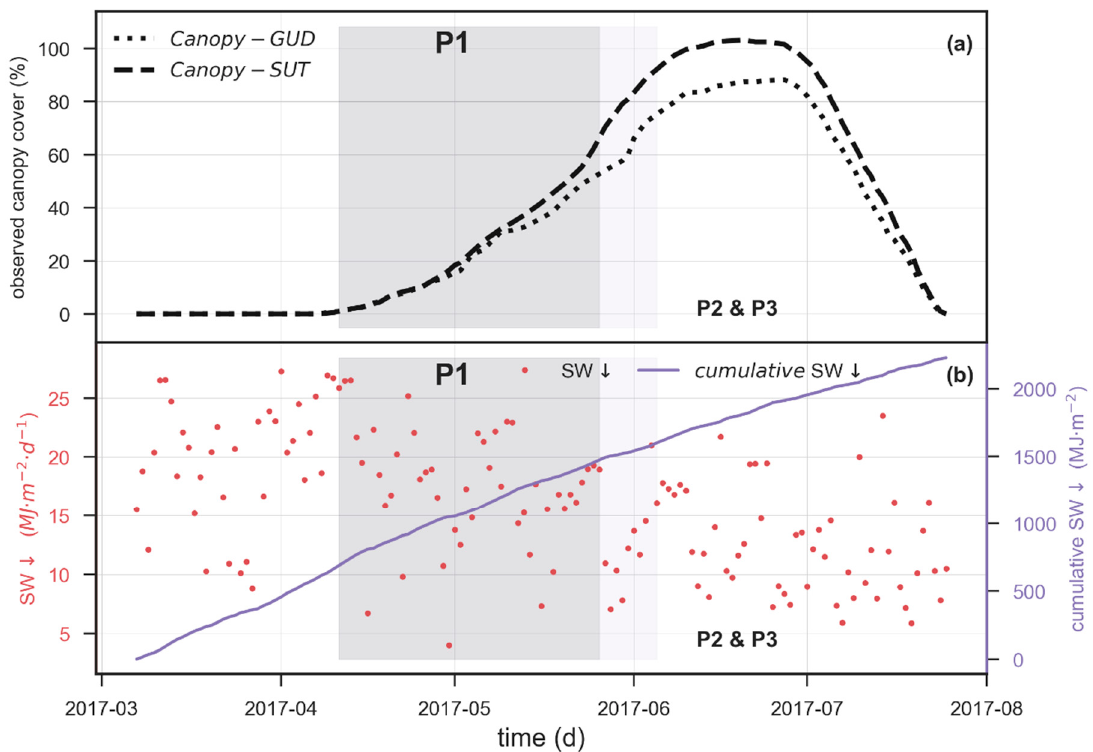
Figure 6. The observed canopy cover (%) ( a ) and the daily SW ↓ (MJ · m − 2 · d − 1 ) ( b ) during the crop growth period in Gircha farm in belg -2017. In ( b ), the cumulative SW ↓ (MJ · m − 2 ) is shown on the right-side y -axis. The cultivars are Gudene (improved) and Suthalo (local). The crop growth phases P1–P3 are slightly different for the two cultivars.